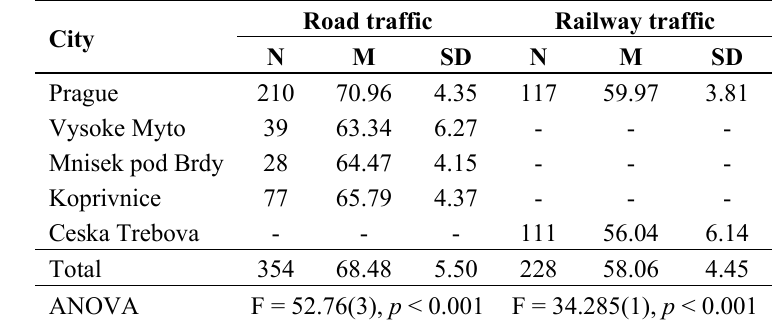
Table 1. Noise exposure (L and ANOVA).